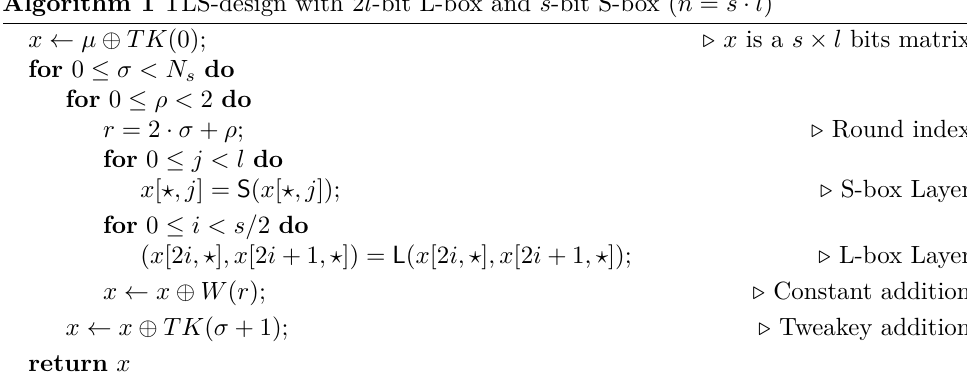
Algorithm 1 TLS-design with 2 l -bit L-box and s -bit S-box ( n = s · l